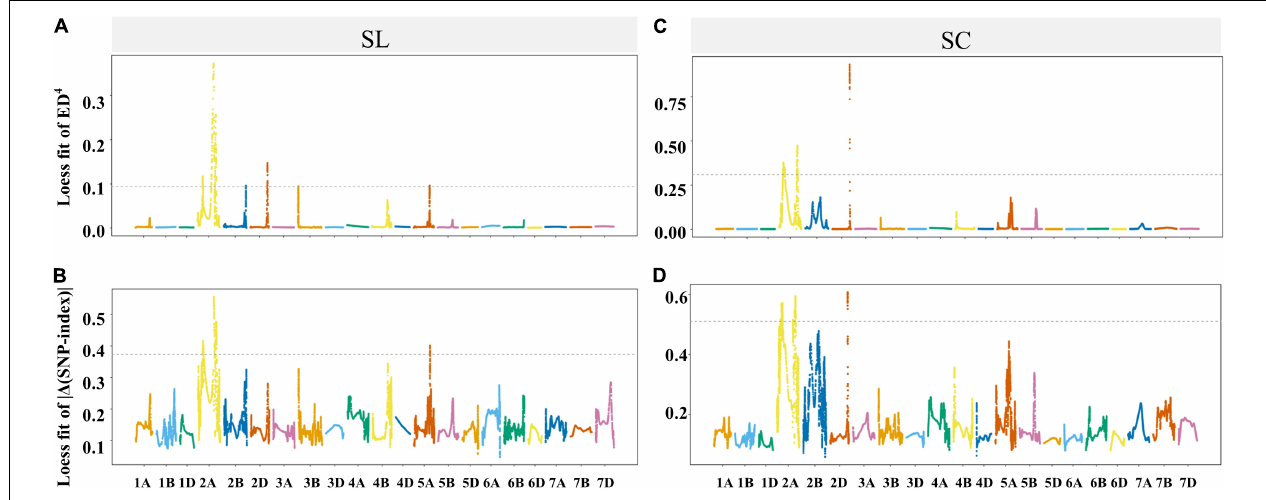
FIGURE 4 | Locally weighted scatterplot smoothing (LOESS) fitting Manhattan for spikelet compactness (SC) and spike length (SL). Panels (A–D) were the LOESS fits of ED4 and | (cid:49) (SNP-index)| for SL and SC, respectively. The cutoff of the two methods for SL and SC are shown by the dotted lines, and the threshold values for (A–D) were 0.0935, 0.3734, 0.3095, and 0.5107, respectively.